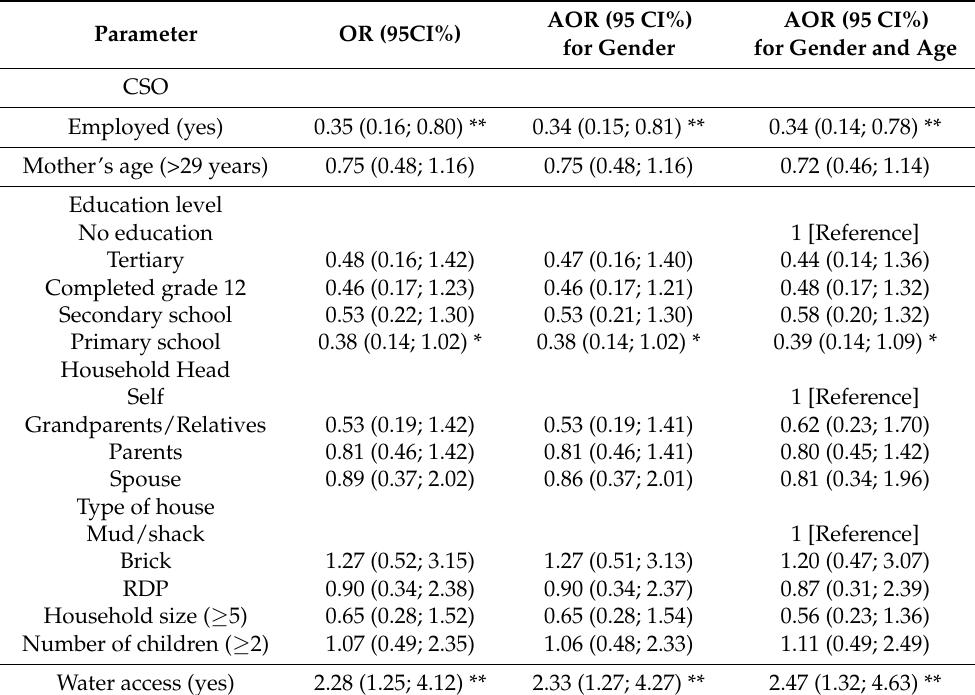
Table 6. Association of CSO with selected co-variates among children.